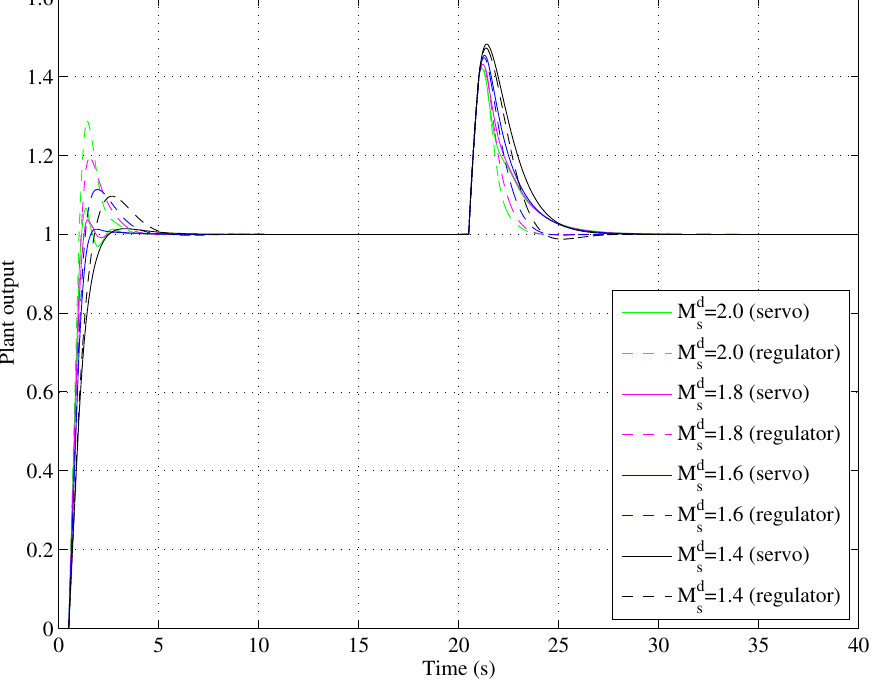
Figure 9. Servo and regulation performances for a =